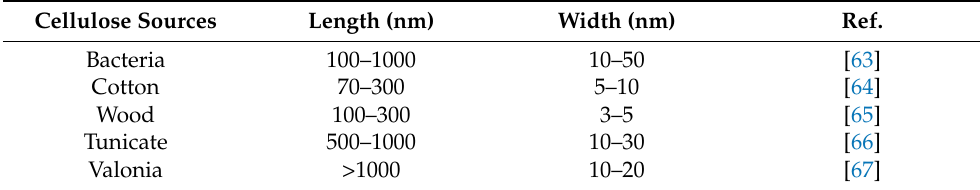
Table 1. List of CNC from various cellulose sources by sulfuric acid hydrolysis. Cellulose Sources Length (nm) Width (nm)